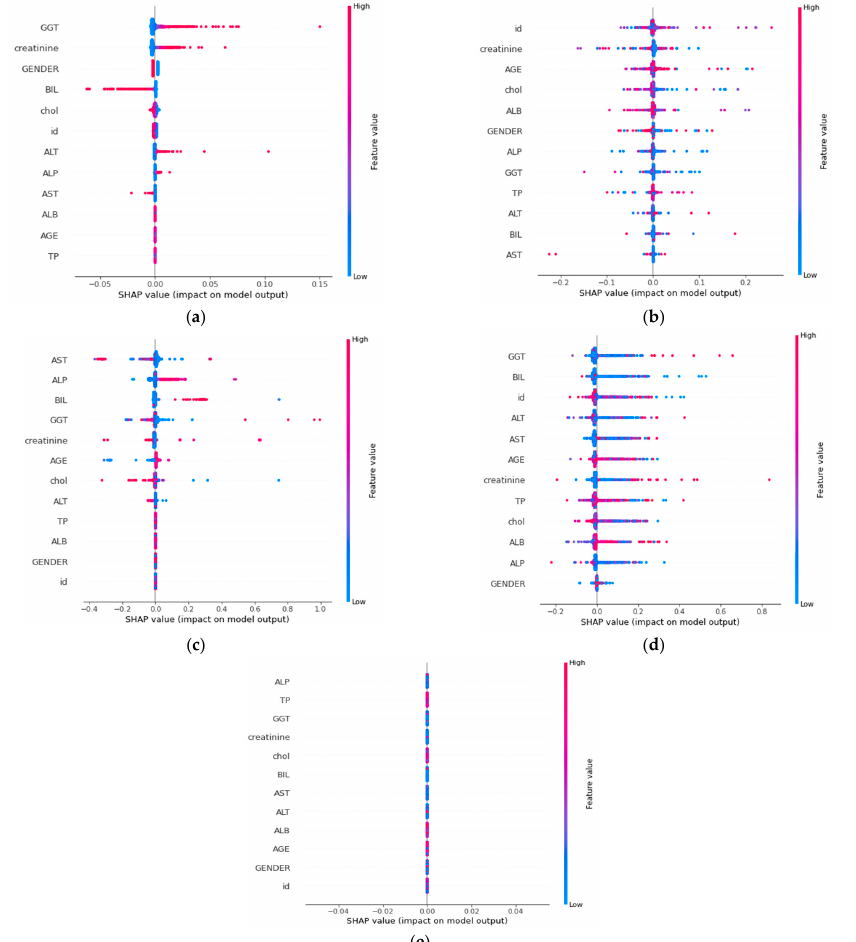
Figure 4. SHAP values under different classifiers. ( a ): LR. ( b ): KNN. ( c ): DT. 5 ( d ): RF. ( e ): NN.